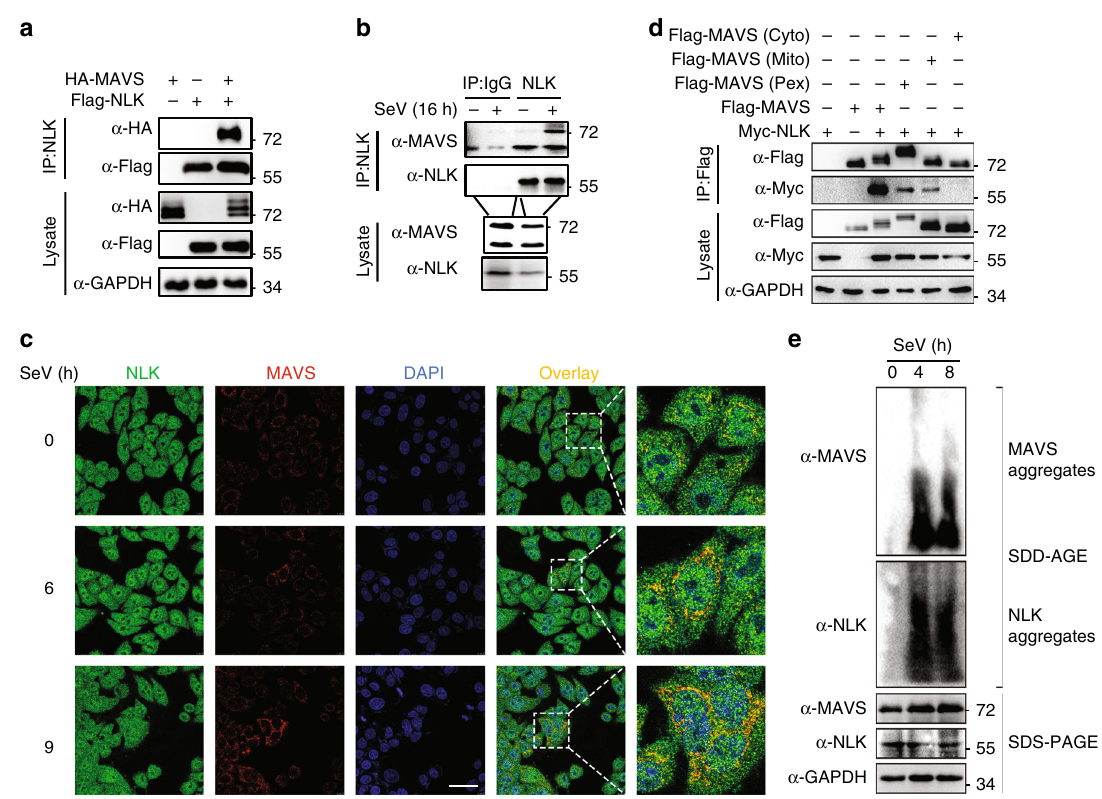
Fig. 5 NLK interacts with MAVS on both mitochondria and peroxisomes. a , b Coimmunoprecipitation analysis of the interaction between NLK and MAVS. a HEK293T cells were transfected with HA-MAVS and Flag-NLK. Coimmunoprecipitation and immunoblot analyses were performed with the indicated antibodies. b Endogenous coimmunoprecipitation was performed using HEK293T cells in the presence or absence of SeV stimulation. The immunoblot analysis was performed with the indicated antibodies. c Immuno fl uorescence analysis of the colocalization of endogenous NLK and MAVS after SeV infection. NLK (green) and MAVS (red) were stained using the indicated antibodies. The nuclei were stained with DAPI (blue). Images were obtained by fl uorescence microscopy. Scale bar is 50 µ m. d Coimmunoprecipitation analysis of the interaction between NLK and the MAVS mutant. HEK293T cells were transfected with wild-type-, cytosol- (cyto), mitochondria- (mito) or peroxisome (pex)-localized Flag-MAVS as well as with Myc-NLK. Coimmunoprecipitation and immunoblot analyses were performed with the indicated antibodies. e HEK293T cells were infected with SeV for the indicated time, and aliquots of the extracts were then analyzed by SDD-AGE or SDS-PAGE. Cyto: cytosol location. Mito: mitochondria location. Pex: peroxisomes location. Data are representative of three ( a , b , e ) or two ( c , d ) independent experiments. Source data, a , b , d , e , are provided as a Source Data fi